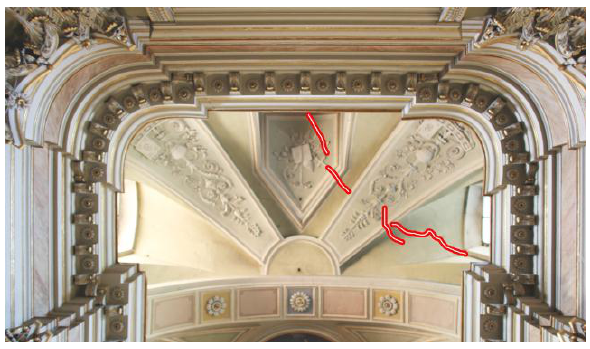
Figure 02. Structure with indication of spatial displacement under applied loan